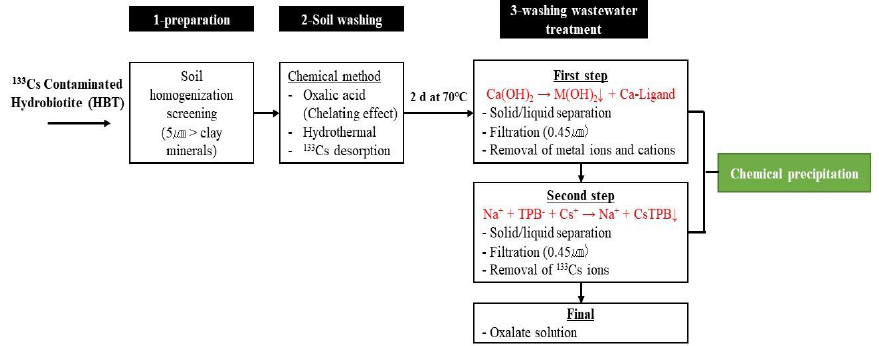
Figure 1. Schematic diagram of soil washing and washing wastewater treatment of cesium (Cs)- Figure contaminated hydrobiotite (HBT).